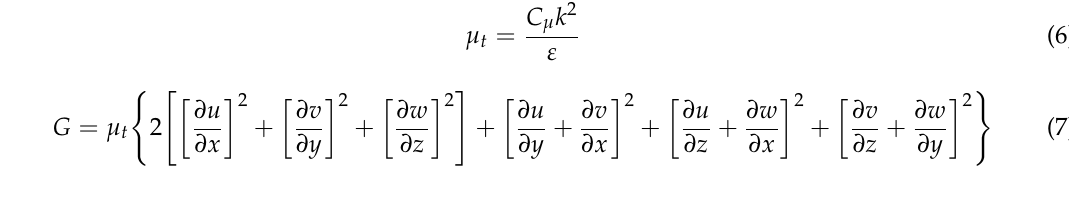
Table 1. Parameters of general